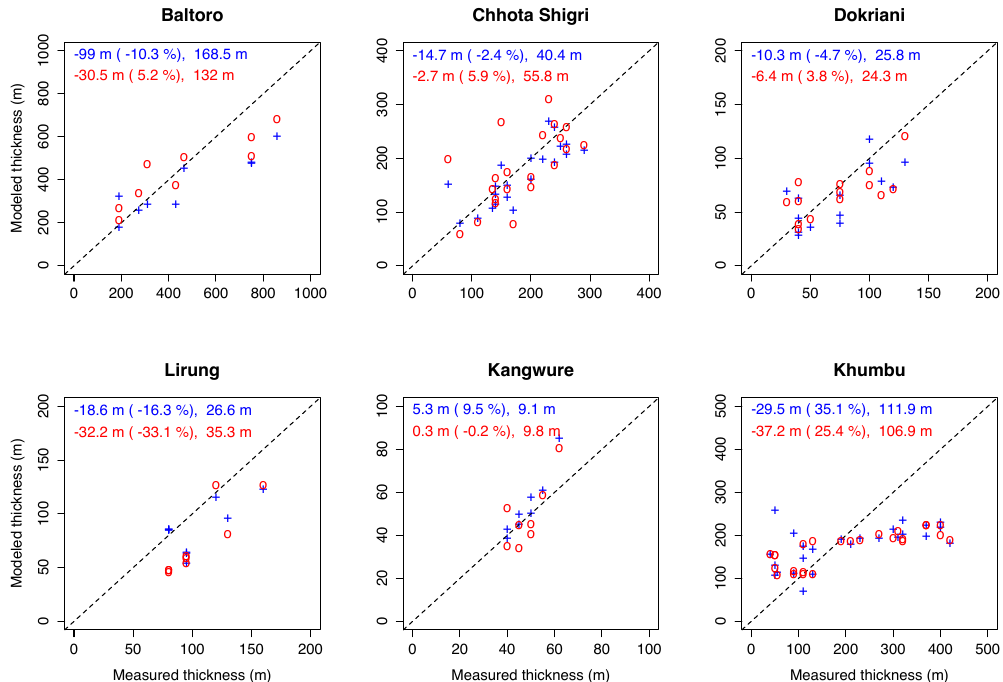
Figure 8. Measured versus modeled local ice thicknesses for results from GlabTop2 (blue pluses) and the HF-model (red circles). Numbers on top-left indicate the mean difference, mean relative mismatch to the measurements (in %), and the